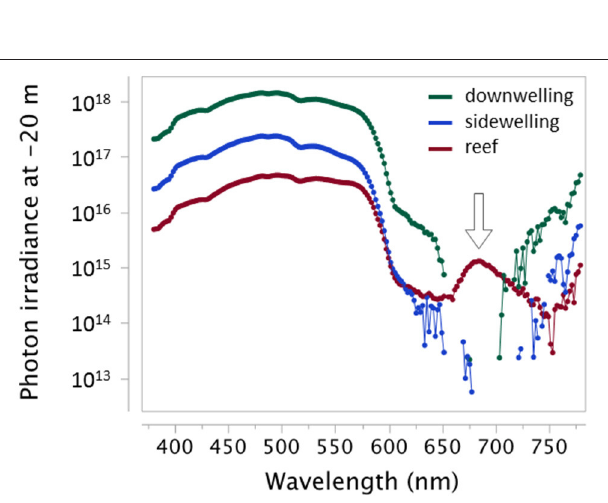
FIGURE 3 | Downwelling light, sidewelling scatter from the open water, and light emitted from a reef in − 20 m showing the distinct red fluorescent emission of the reef at this depth (arrow). Measured as photon irradiance (photons.s − 1 .m − 2 .nm − 1 ) using a calibrated PhotoResearch PR 670 with CR-670 cosine corrector in El Quseir, Egypt (sunny, midday, March 2013). Raw data shown as connected points. Missing points are wavelengths at which the signal fell below the detection threshold. Note log 10 y